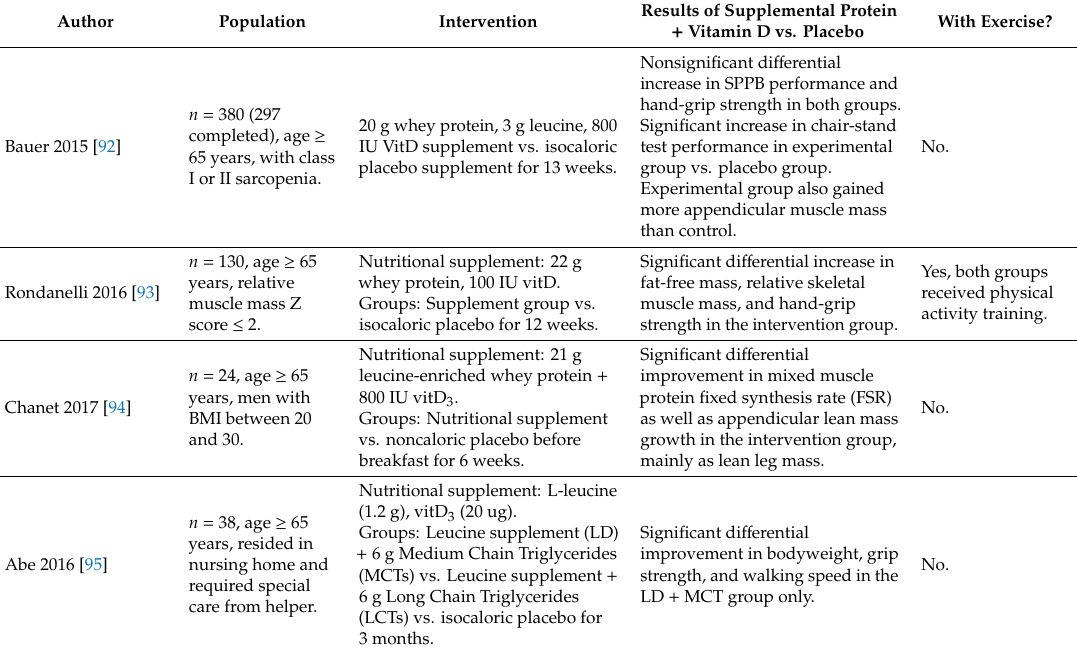
Table 3. Randomized controlled trials of combination therapy and